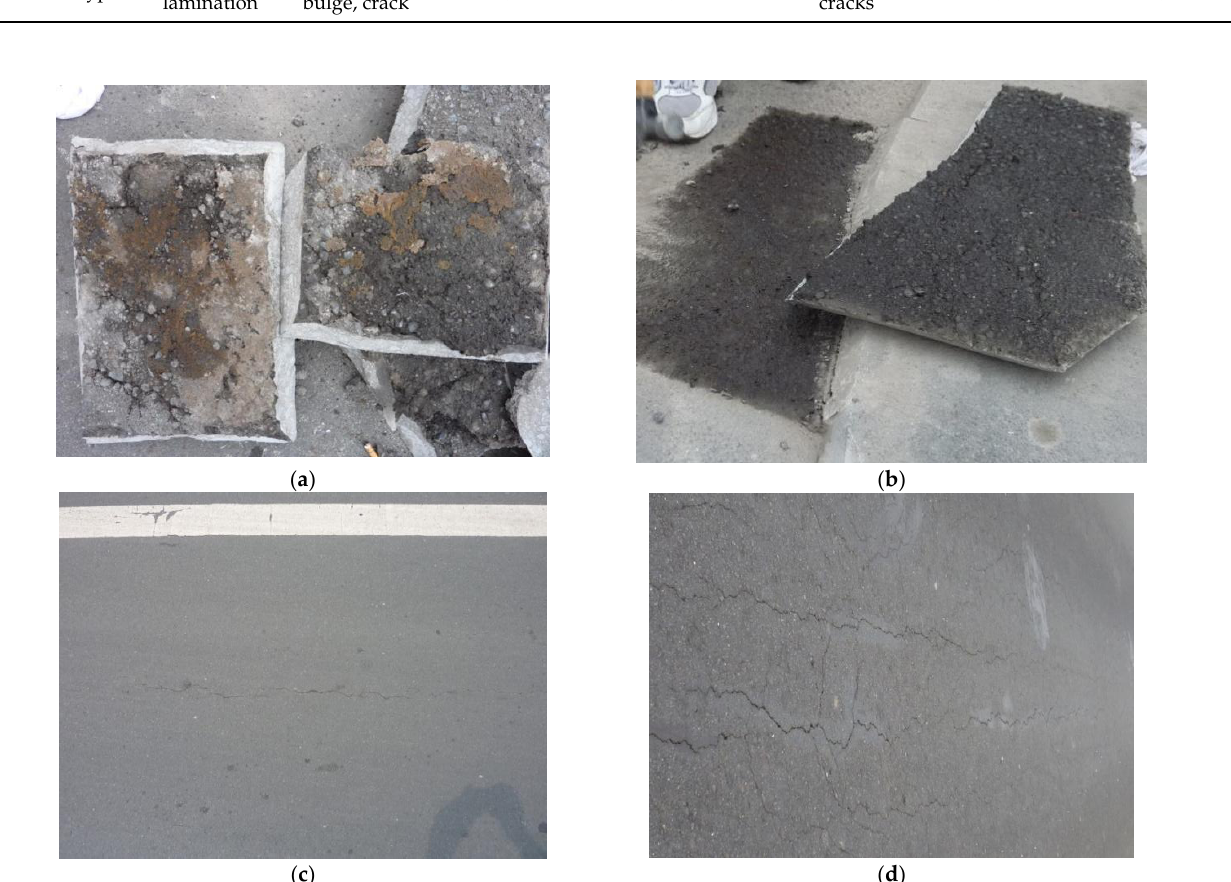
Figure 1. Delamination and cracking of the paving layer: ( a ) Early stage of longitudinal cracking of epoxy asphalt paving; ( b ) Longitudinal cracking and web cracking of epoxy asphalt paving; ( c ) Condition of binder layer for paving delamination cracking; ( d ) Damp condition of binder layer for paving delamination and cracking. Table 1. Typical steel deck pavement structure options.